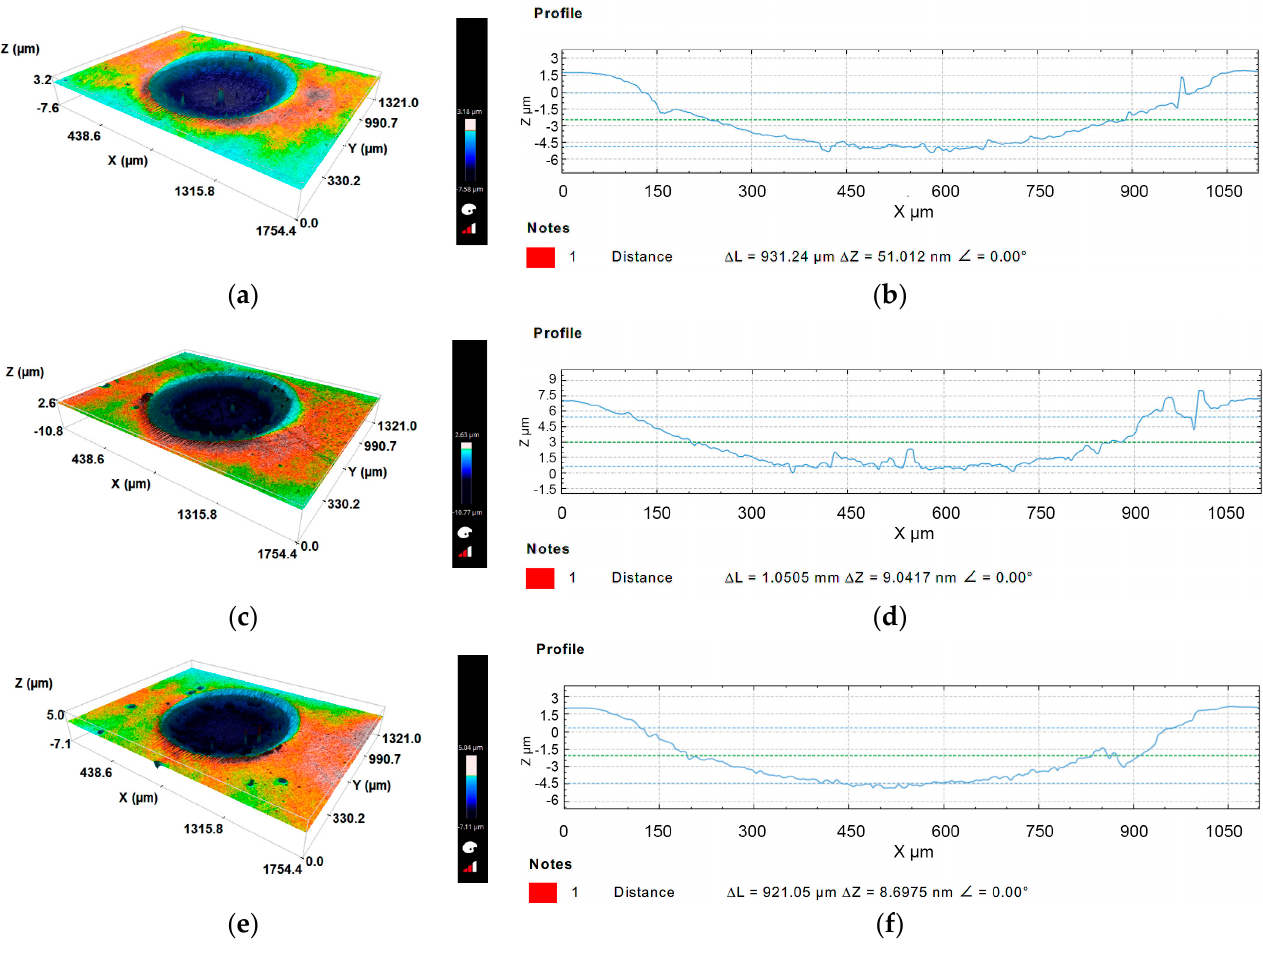
Figure 9. Crater surface topography analyzed by 3D profilometry for a load of 0.20 N: ( a ) slurry concentration (SC) 0.25 g/cm 3 ; ( b ) detail of roughness in profile (SC) 0.25 g/cm 3 ; ( c ) slurry concentration 0.35 g/cm 3 ; ( d ) detail of roughness in profile (SC) 0.35 g/cm 3 ; ( e ) slurry concentration 0.45 g/cm 3 ; ( f ) detail of roughness in profile (SC) 0.45 g/cm 3 .